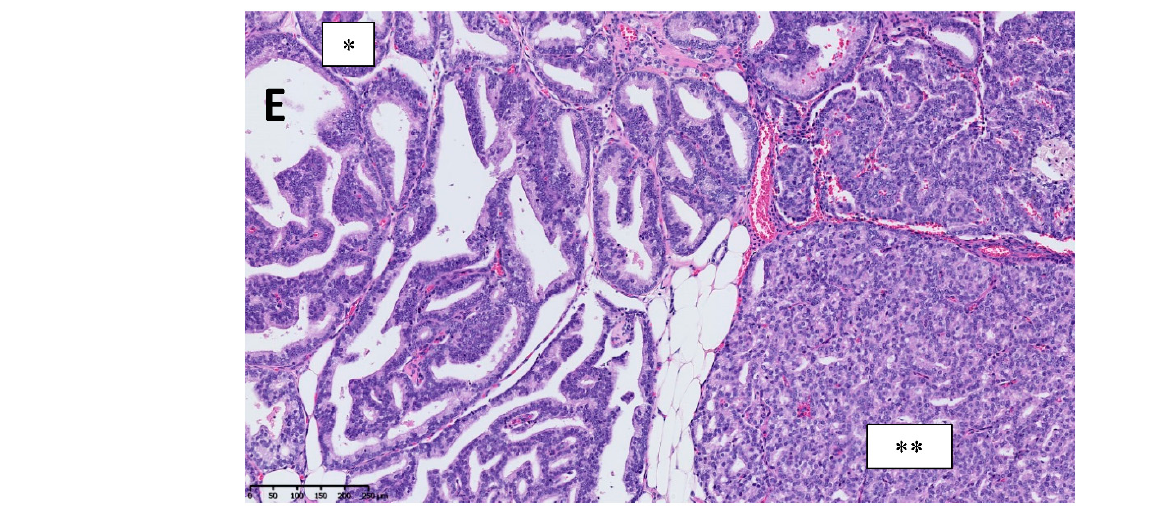
Figure 3. Discordant findings between PSMA PET/CT and WB-MRI/DWI: false negative observation of metastatic lymph node by WB-MRI/DWI in 62-year-old patient with prostate cancer at BCR (rapidly rising PSA up to 3.5 ng/mL after radical prostatectomy and pelvic irradiation). ( A , B ) PSMA PET/CT: reformatted coronal CT ( A ) and PET ( B ) images show unique 10 mm radiotracer-positive (SUVmax 12) left iliac lymph node considered as metastatic on the PET image (arrows in ( A , B )). ( C , D ) WB-MRI/DWI images: corresponding reformatted high resolution T1 ( C ) and diffusion-weighted ( D ) MRI images show single left lymph node (arrows in ( C , D )) that was not considered as metastatic based on its size (small diameter < 10 mm). ( E ) Hematoxylin and eosin stained section of resected node after robotic-assisted salvage lymphadenectomy shows the presence of a PCa metastasis with a mixed intra-ductal (*) and cribriform (**) morphology (original magnification ×300; scale bar in lower left corner).